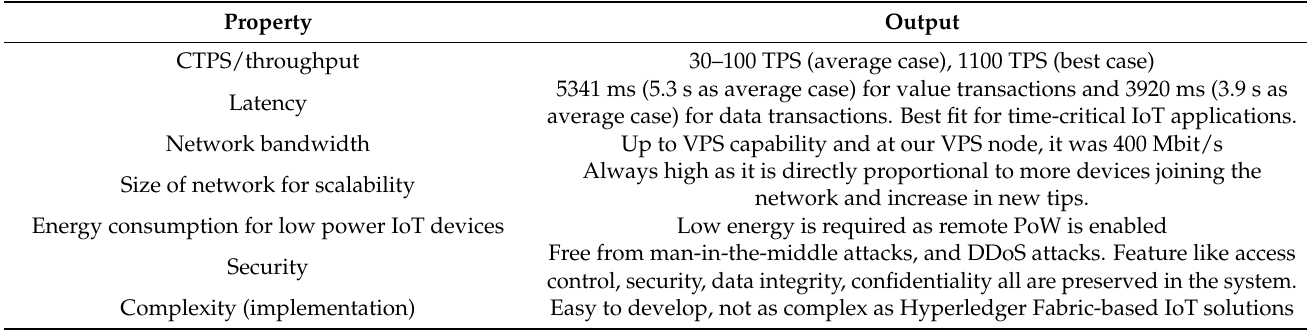
Table 9. Performance output against research